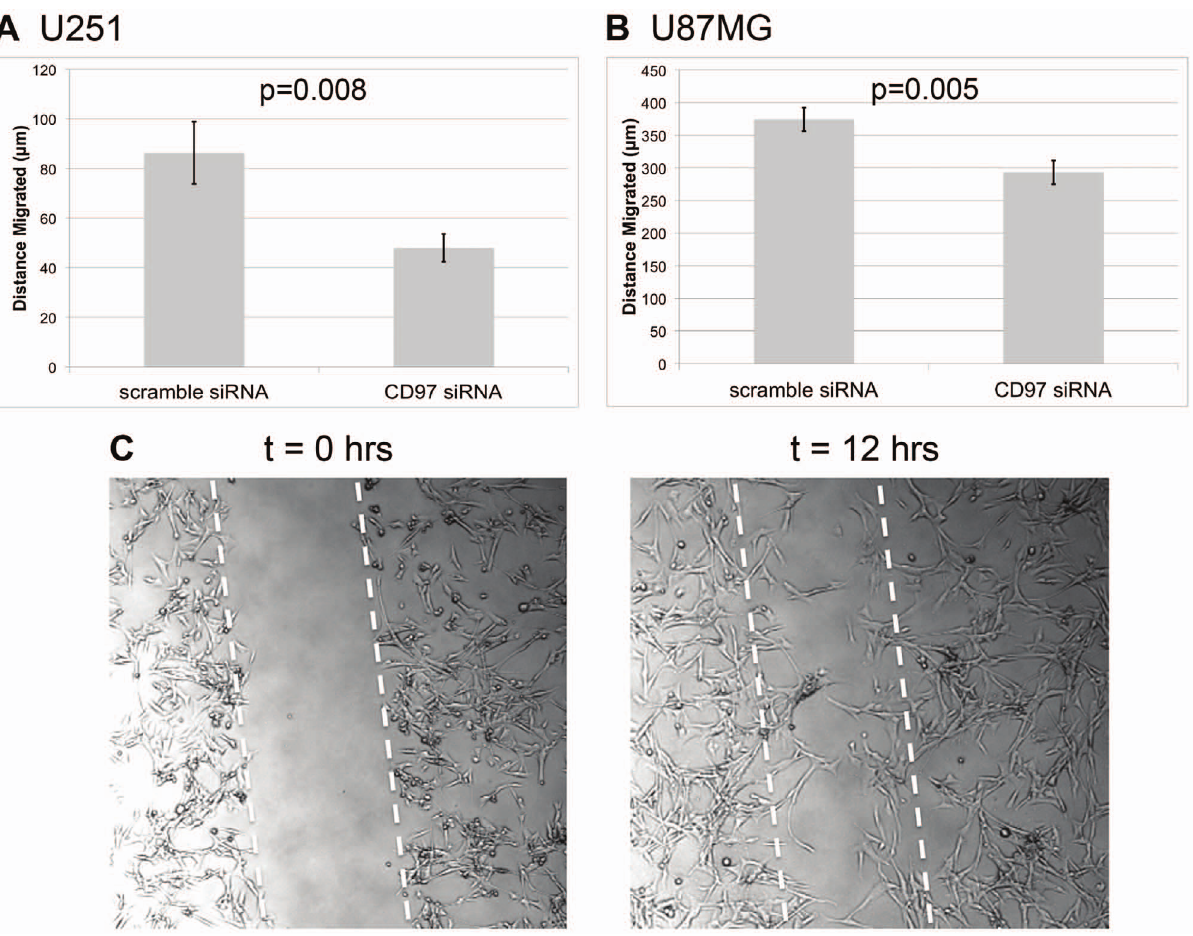
Figure 5. CD97 is associated with cell migration. U251 and U87MG cells were subjected to siRNA-mediated knockdown of CD97. In U251 cells, knockdown of CD97 decreased migration by 44% (p=0.02) (A). In U87MG cells, knockdown of CD97 decreased migration by 22% (p=0.005) (B). Migration was quantified by measuring the difference in distance between the leading edge at the initiation of the experiment and after 12 hours of incubation (C).